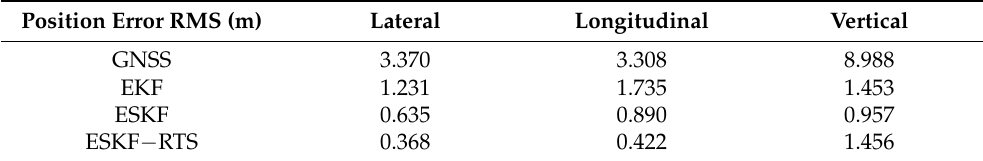
Table 4. RMS values of localization errors for different algorithms (Serpentine 2).